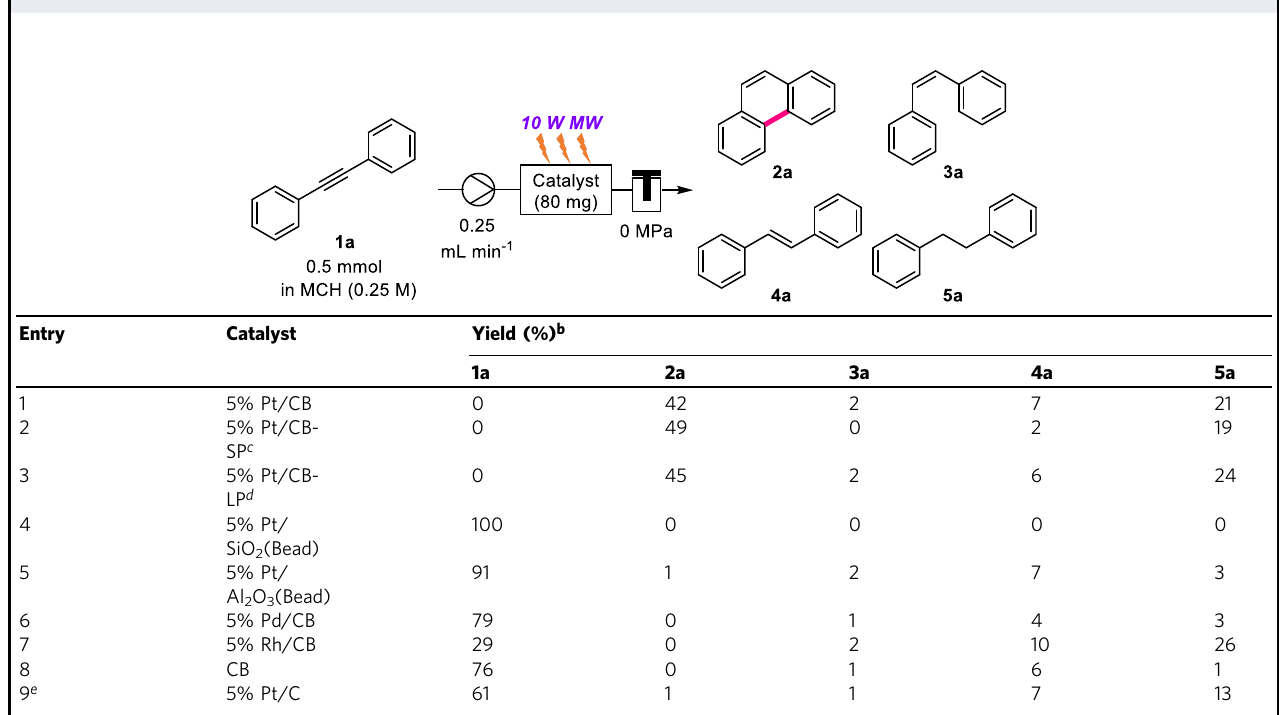
Table 1 Effects of platinum group metals and CB of catalysts a .